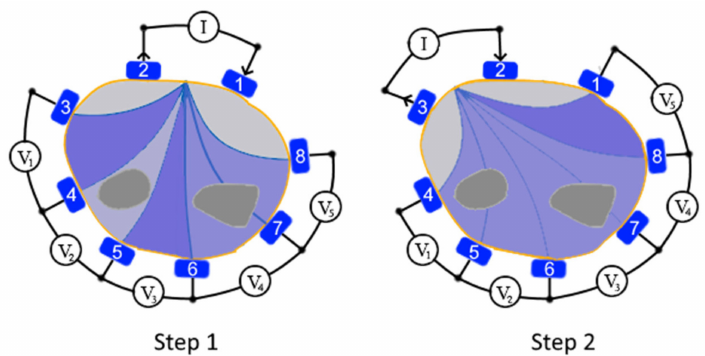
Figure 3. Illustration of two excitation steps during measurement of cross-sectional impedances between pairs of electrodes (four-pole measurement schemes with eight electrodes). Measurement is repeated for all electrode pairs. A higher voltage di ff erence is shown in a brighter blue colour. Objects with a high impedance within the cross-section are shown in